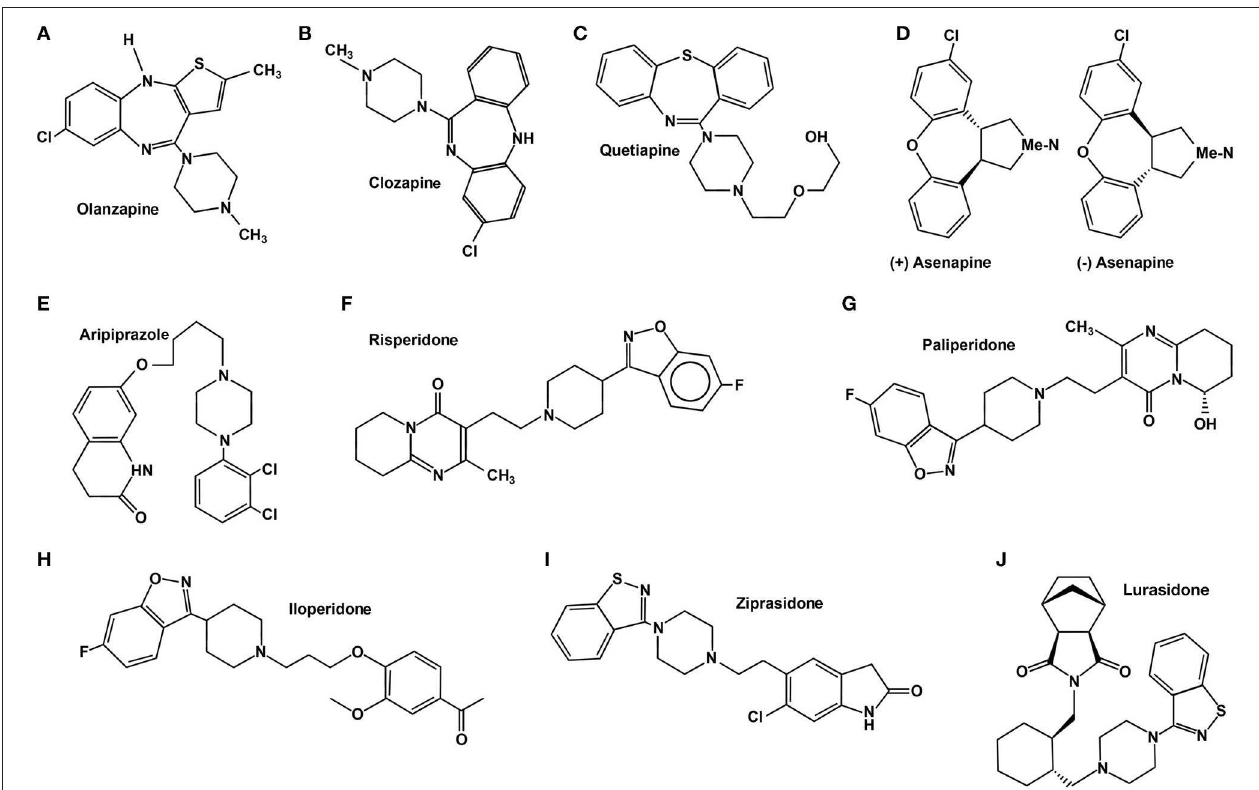
FIGURE 1 | Chemical structure of atypical